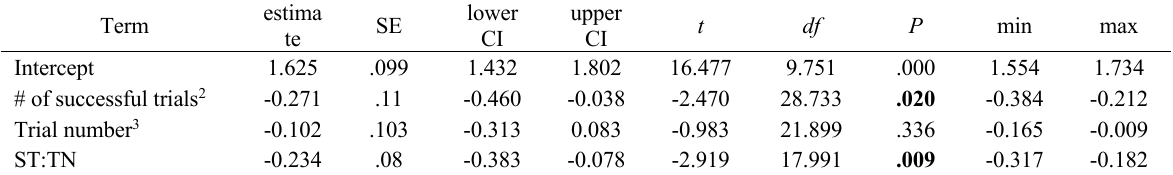
Results of GLMM Model Two of Number of Successful Trials and Trial Number and their Interaction on Log-Time-to-Solve 1